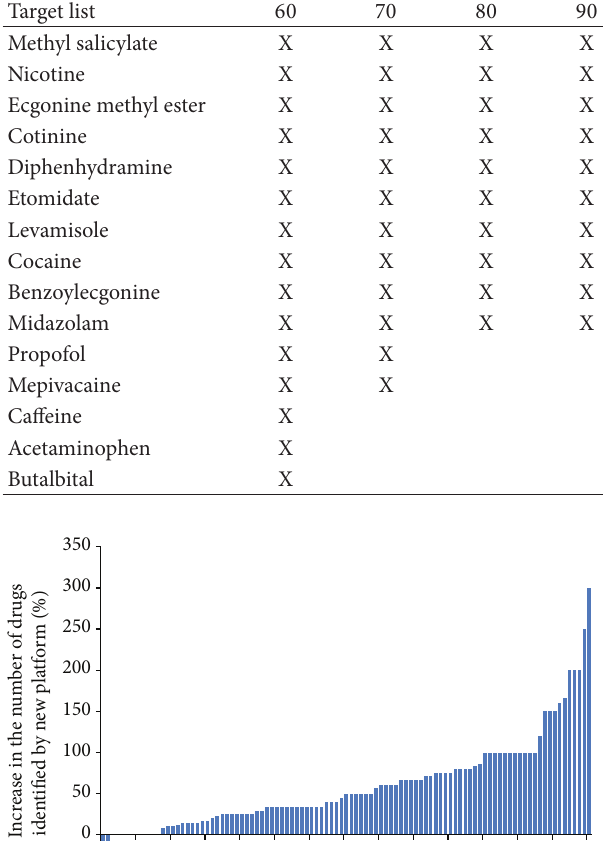
Table 1: List of drugs reported (X) by AMDIS for four MMFs for a patient sample. Number of drugs reported reduced from 15 with an MMF of 60 to 12 (MMF = 70) to 10 (MMF = 80 and 90). Based on such investigation, an MMF of 80 was identified to exclude all verifiable false positives and low-level carryovers from previous injection from the target list.